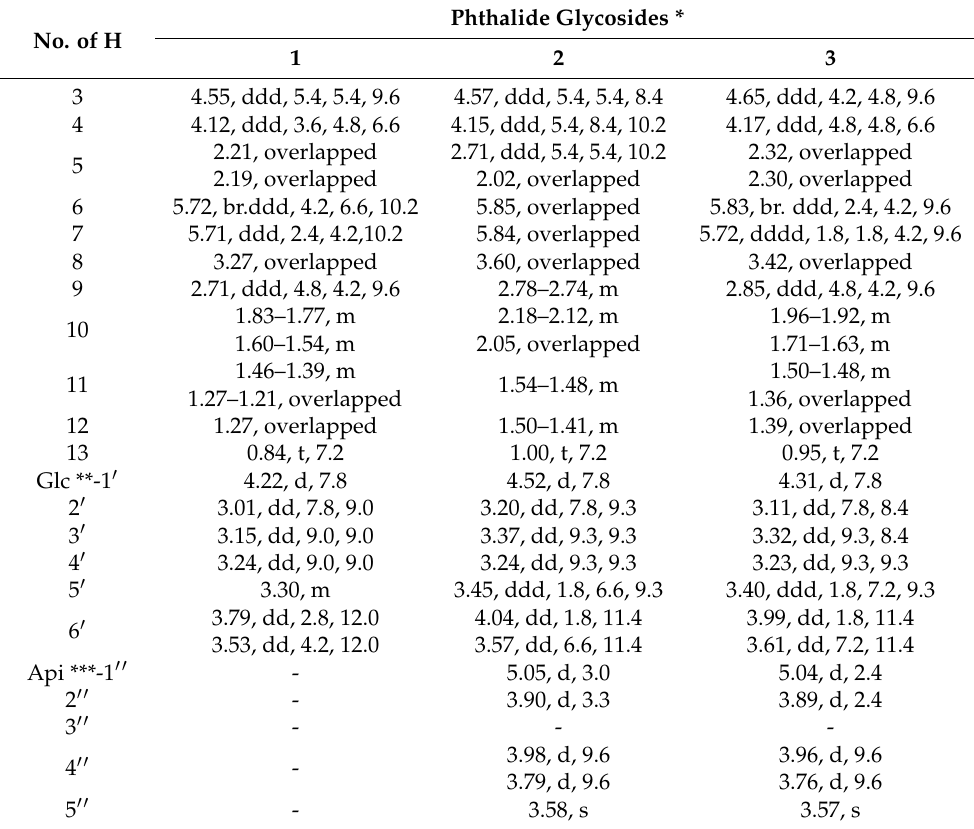
Table 2. 1 H-NMR data on the phthalide glycosides from the rhizome of Cnidium officinale Makino (600 MHz, CD 3 OD, δ H , coupling pattern, J in Hz).